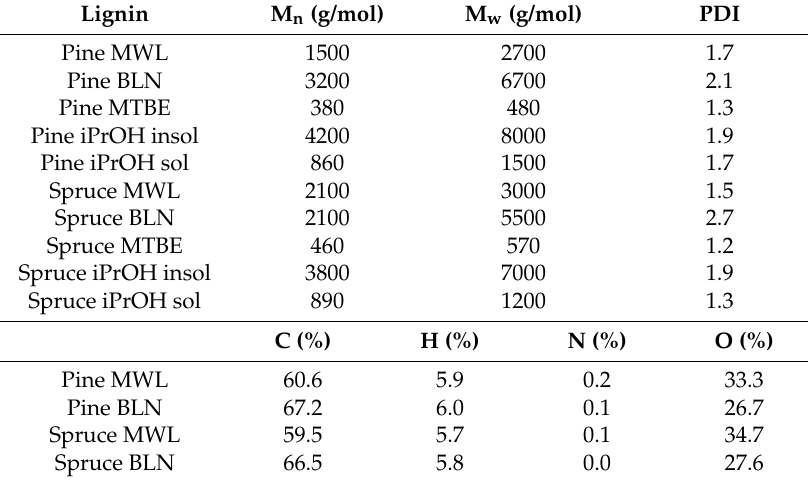
Table 3. The molar mass of the different lignin fractions and elemental analysis of the unmodified lignin and the